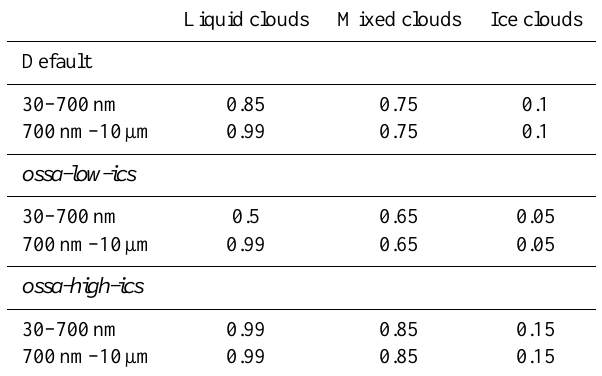
Table 4. In-cloud scavenging coefficients for soluble particles in stratiform clouds used in different runs. Default values are used in all other runs except in ossa-low-ics and ossa-high-ics . Scavenging coefficients for insoluble particles were kept at the model default values in all runs. Liquid clouds Mixed